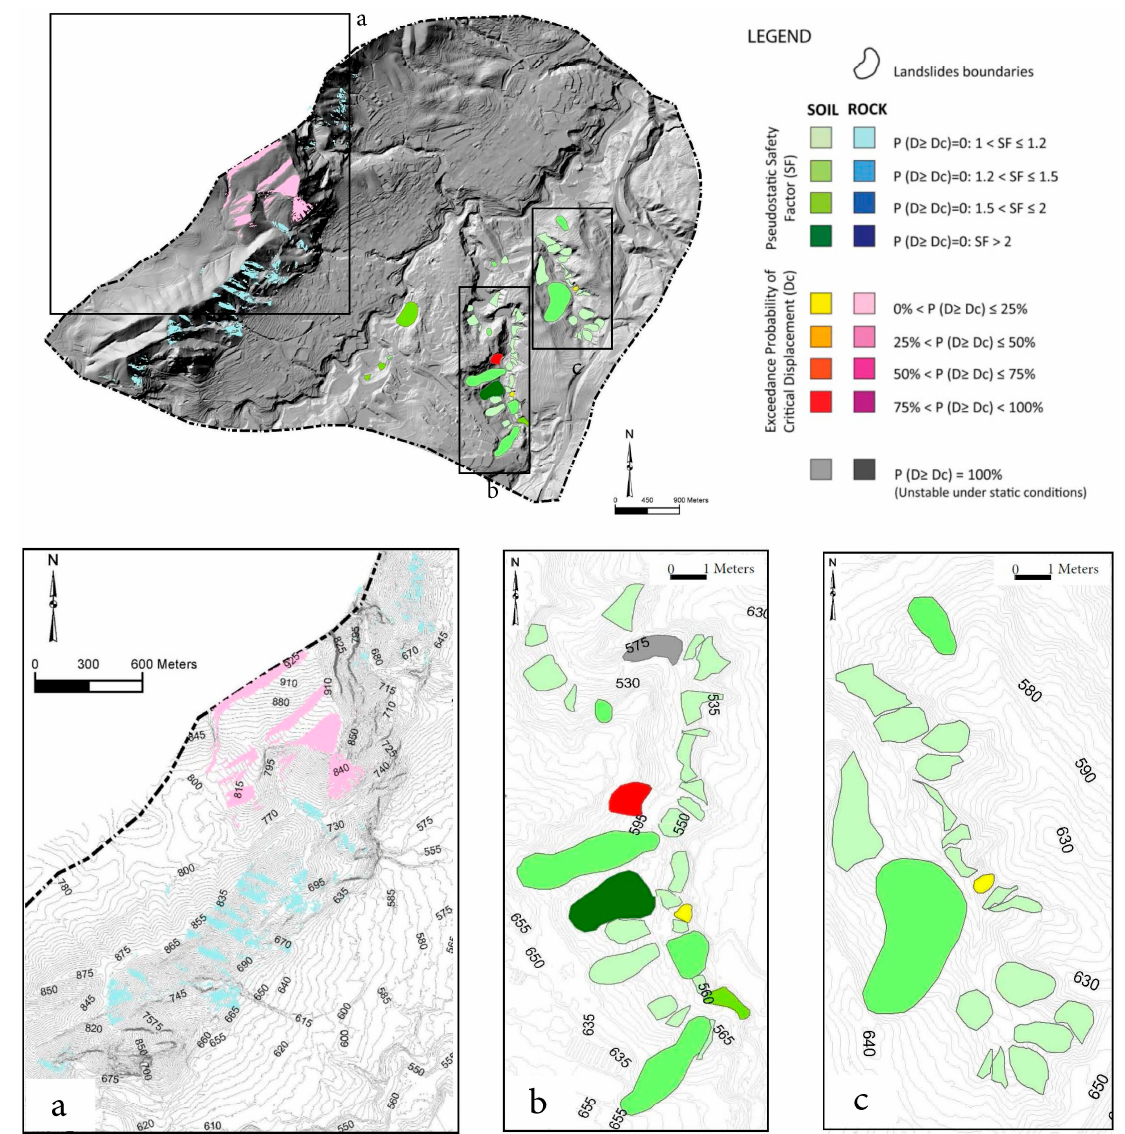
Figure 12. Resulting scenario by PARSIFAL obtained in the Alcoy urban area for RT = 475 years in dry conditions (the zoomed areas—a, b, c—are bounded in the key map).